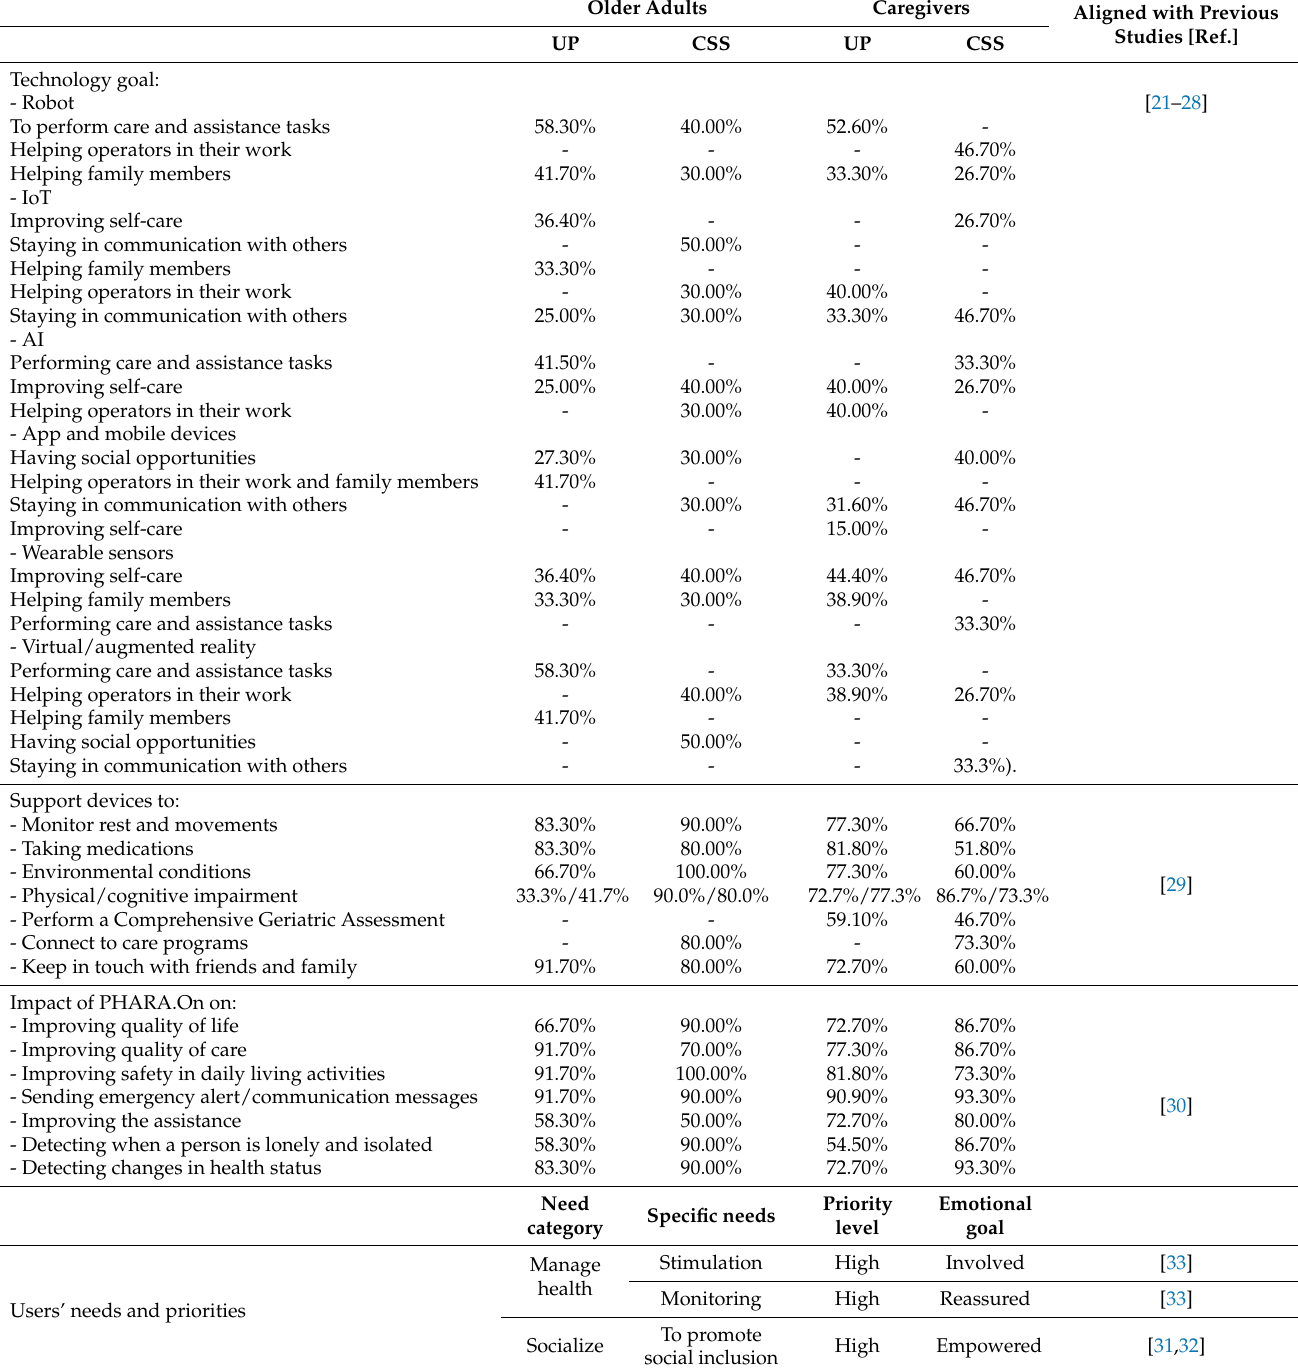
Table 4. Summary table of the results obtained and comparison with respect to previous